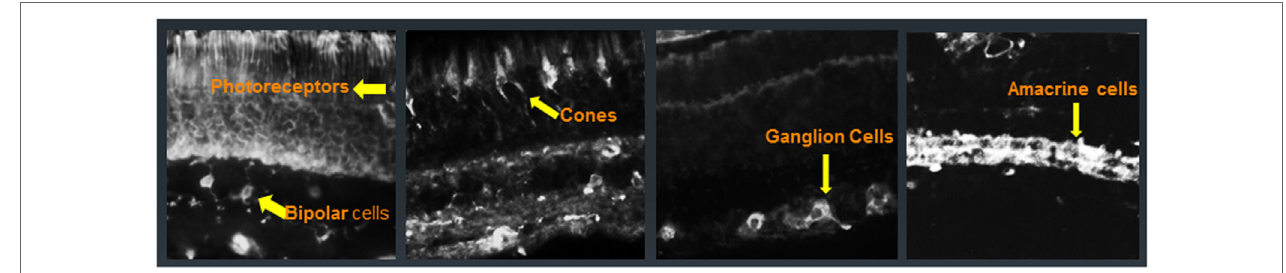
FigURe 3 | Immunofluorescent labeling of the human retina with cancer-associated retinopathy patients’ anti-retinal autoantibodies (AAbs) specific for different cellular structures. From left to right: AAbs label photoreceptor cells and bipolar cells, cone photoreceptors, ganglion cells, and amacrine cells; arrows point at immunofluorescent